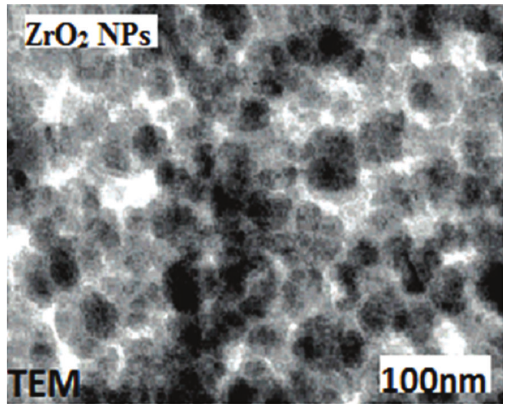
F 3: TEM images of ZrO